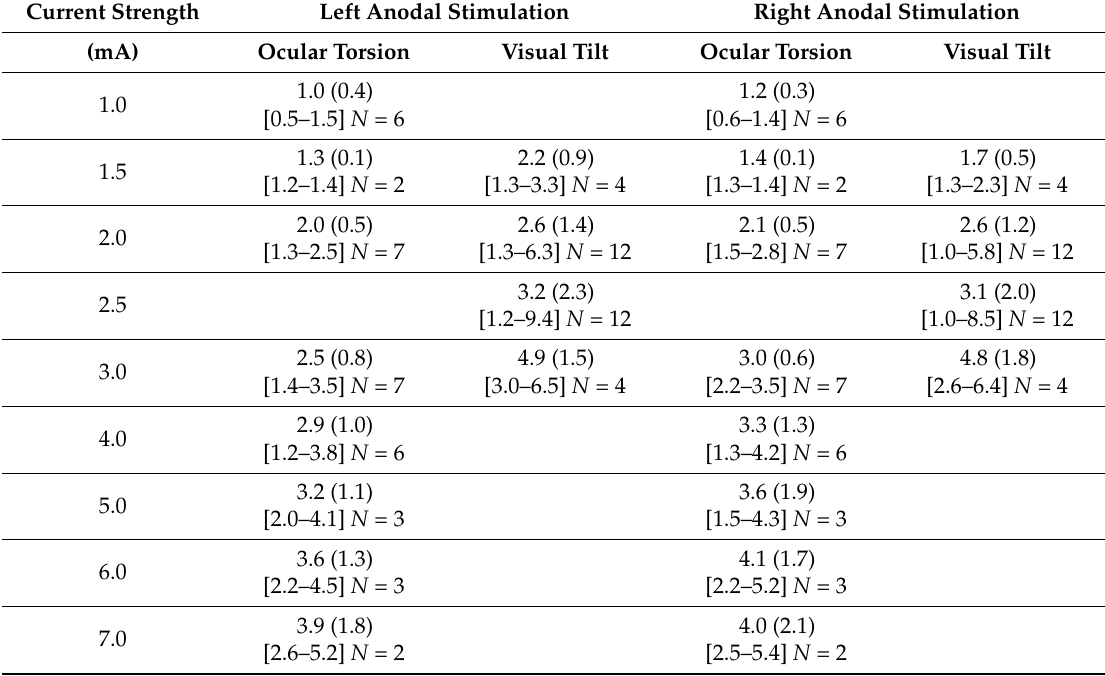
Table 1. Results from Zink et al. (1998), Electroencephalography and Clinical Neurophysiology , 107 , pp. 200–205. Zink and colleagues applied unipolar direct current with the anode on the right or left mastoid. They measured ocular torsion and visual tilt in degrees of rotation at different galvanic vestibular stimulation intensities. Results reported by Zink and colleagues (and reprinted here) are the average rotation (unsigned), the standard deviation (between round brackets), the minimum and maximum measured values (between square brackets), and the number of participants tested in a particular cell. Ocular torsion occurred towards the anode, whereas visual tilt occurred away from the